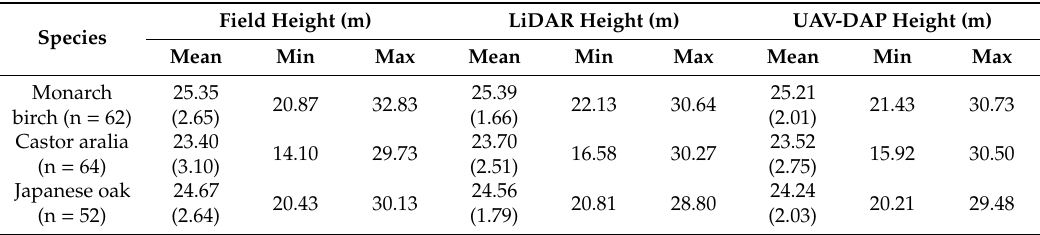
Table 3. Observed tree height from field, LiDAR and UAV-DAP (standard deviation in parenthesis).